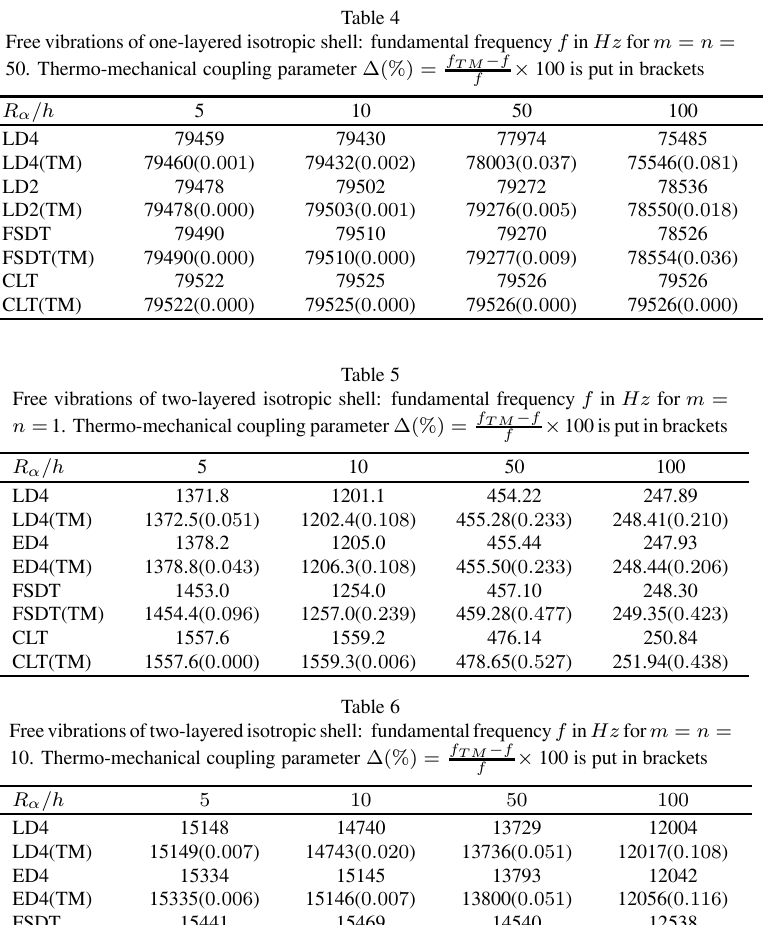
Table 4 Free vibrations of one-layered isotropic shell: fundamental frequency f in Hz for m = n =